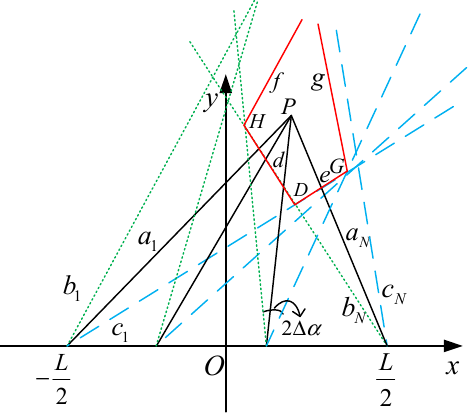
line from the n th array element to P ( x P , y P ) is marked as line a n , n = 1, 2, 3, . . . , N , which is the angular bisector of 2 ∆ α , and the line towards the negative angle direction is line b n , while the line towards the positive angle direction is line c n . The intersection point of line c 1 and line b N is marked as point D . The intersection point of line c 1 and line c 2 is marked as point G . The line g parallel to line c N is started from point G , and the connecting line between G and D is marked as line e . The intersection point of b N − 1 and b N is marked as point H , and line f parallel to b 1 is started from H . The connecting line between H and D is marked as line d . Then the effectively compensated area of the array for B ( x B , y B ) based on P ( x P , y P ) is within the area encircled by four sides of g , e , d , and f .